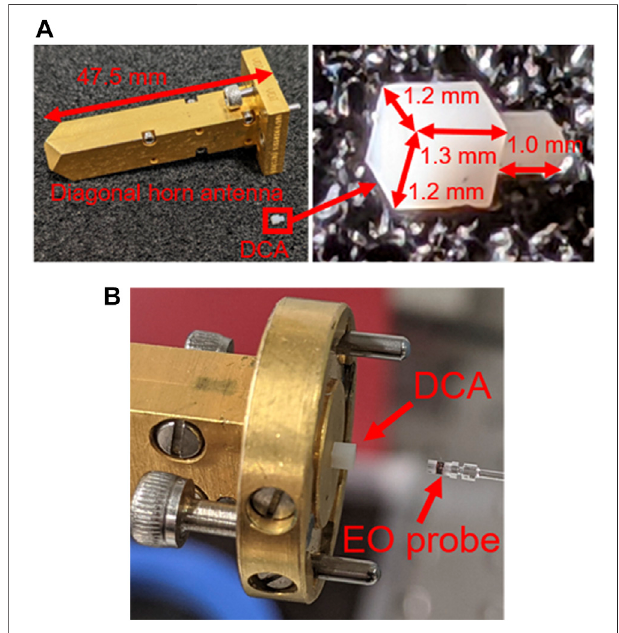
FIGURE 2 | Photographs of the proposed DCA (A) Comparison with a diagonal horn antenna. The antenna aperture size is 1.2 mm × 1.2 mm, and the antenna length is approximately 1.3 mm. The DCA features a protruded section toallowconnectionwithaWR-3.4waveguide (B) Photographof DCA connected to a WR-3.4